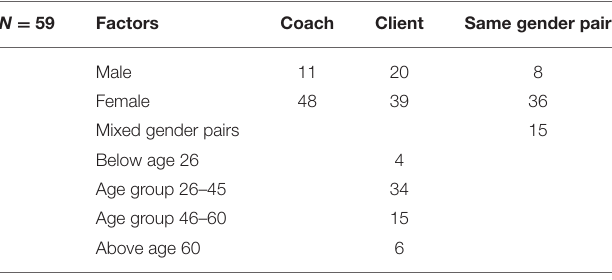
TABLE 1 | Overview of demographic factors as predictors N = 59.